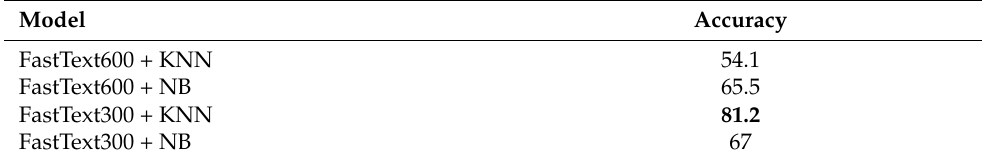
Table 3. Experiments on lite dataset using FastText.